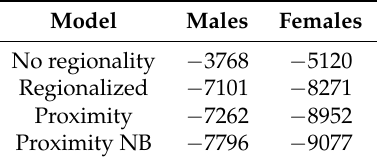
Table 2. Comparison of AICs